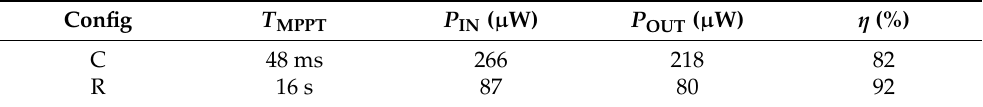
Table 3. Comparison results of the power generation test on the marine environment. Config T MPPT P IN ( µ W) P OUT ( µ W) η (%) C 48 ms 266 218 82 R 16 s 87 80